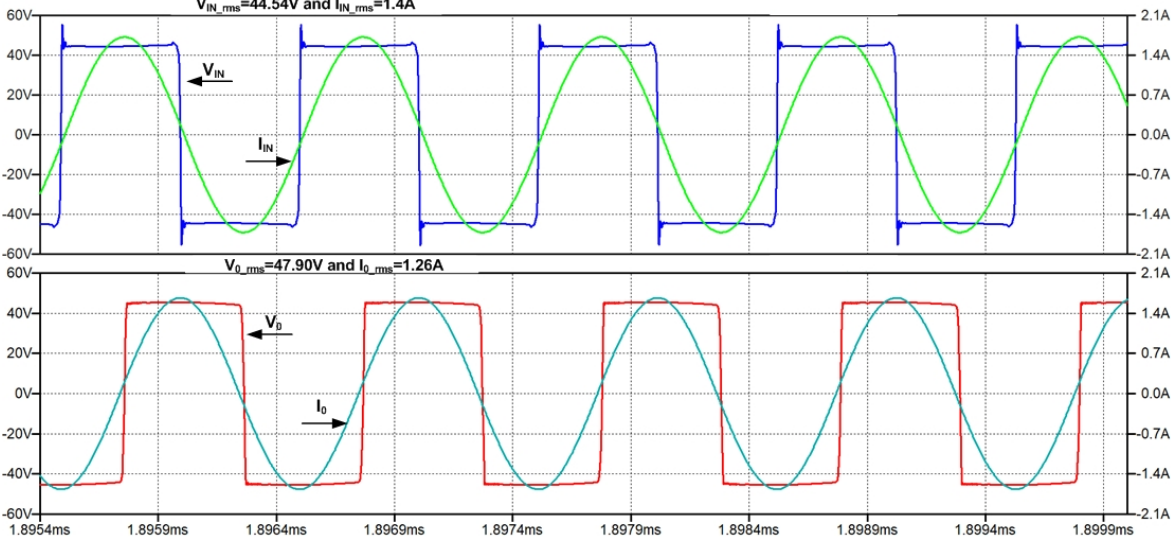
Figure 16. Input voltage (red), output voltage (blue), input current (red), and output current (blue) for P o = 50 W.